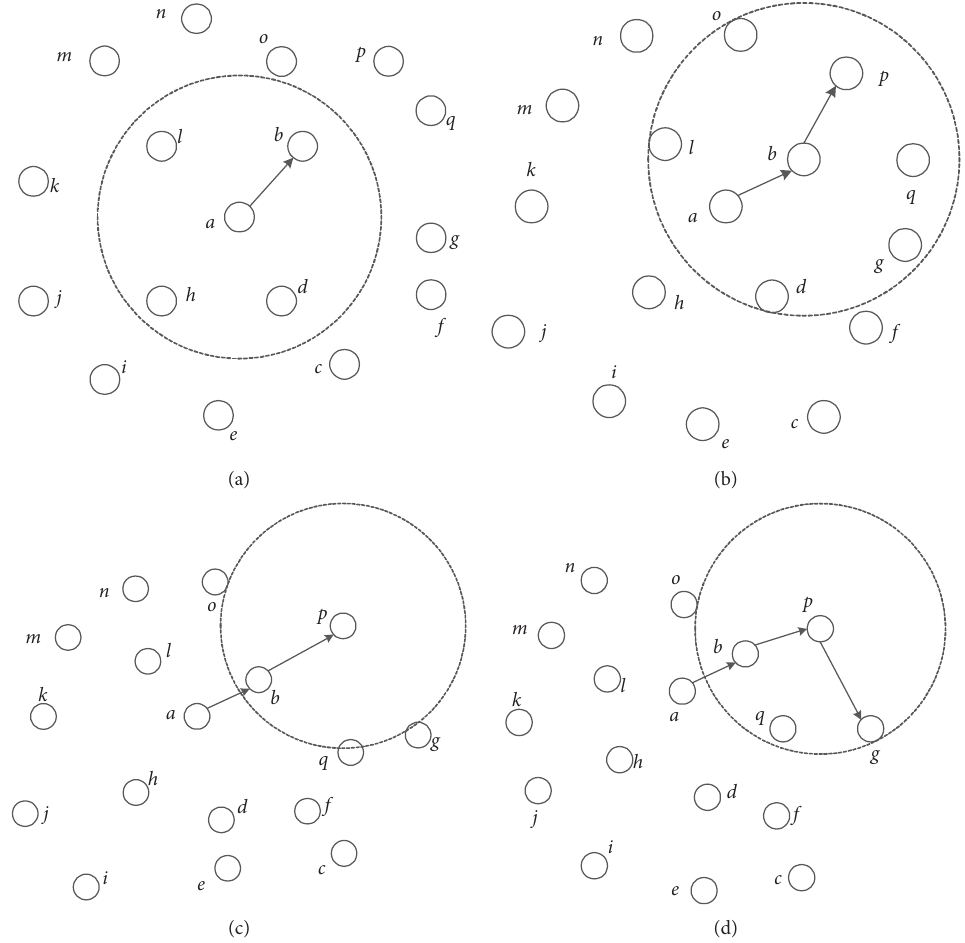
Figure 9: Example for nodes random selection algorithm in mobile networks. (a) t � t